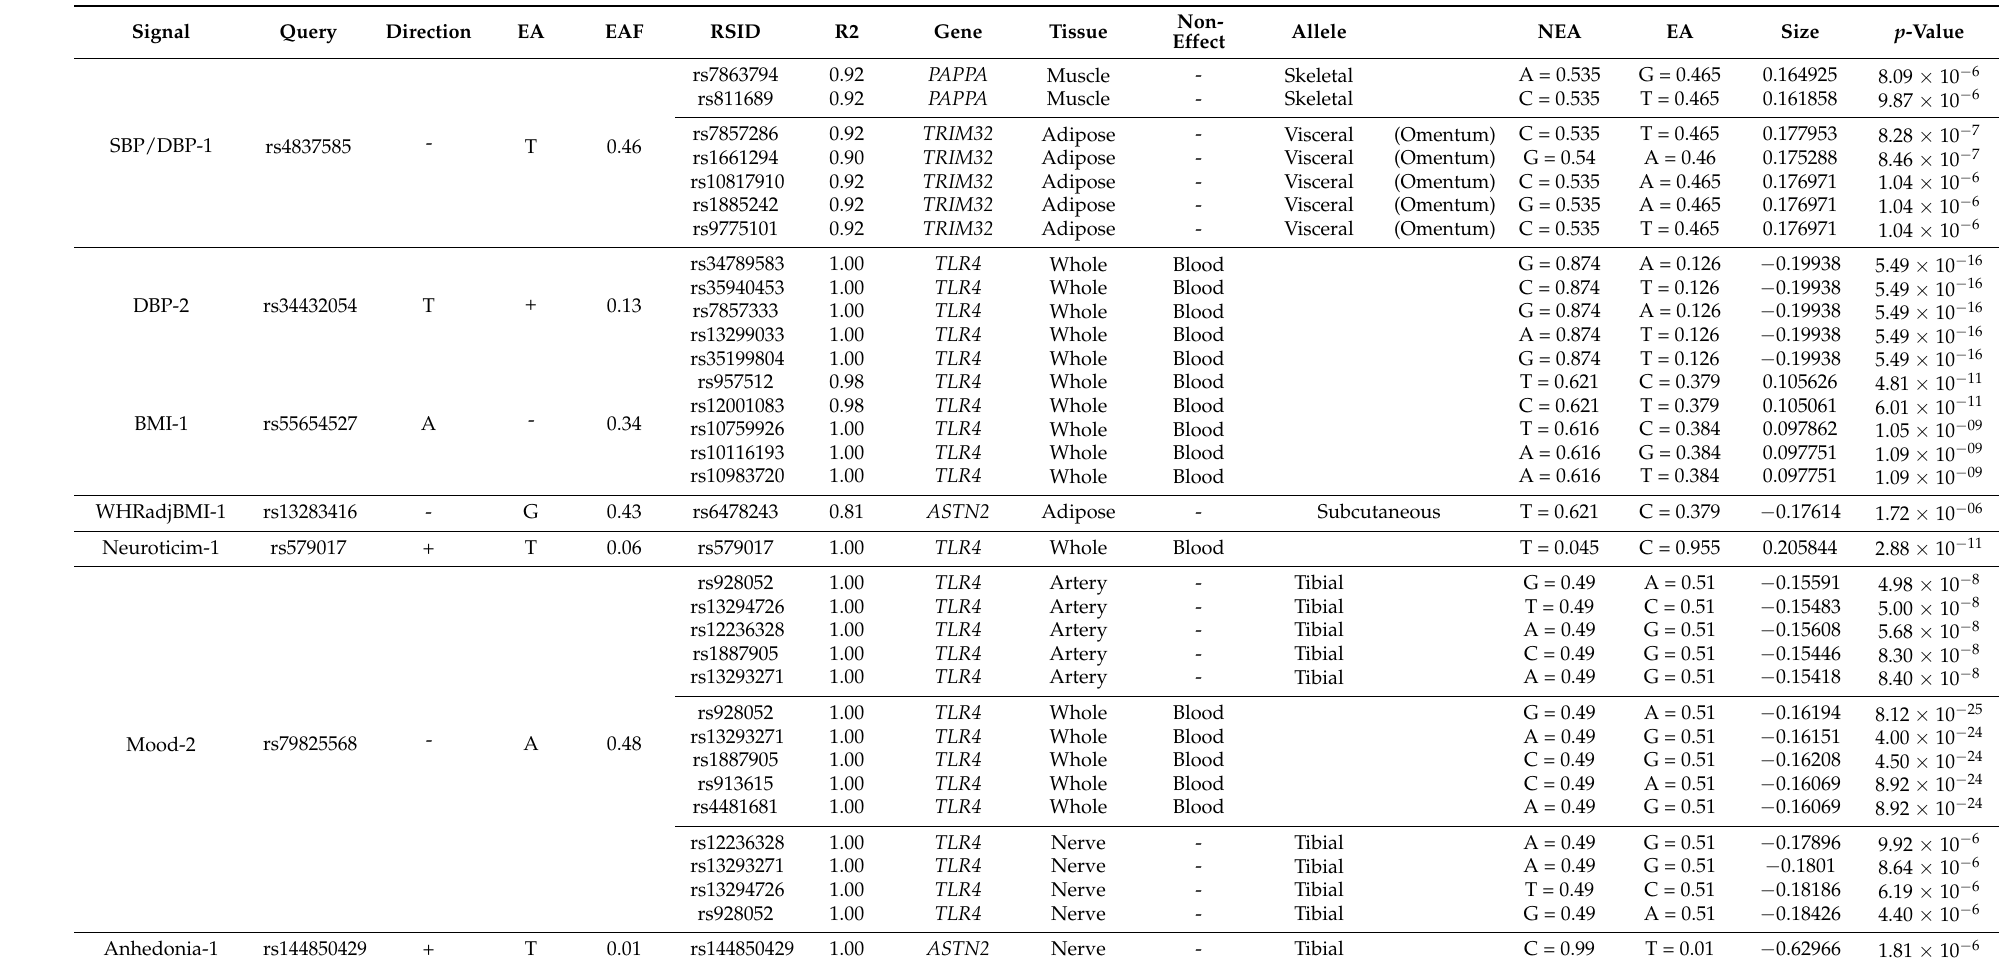
Table 4. Genotype-specific expression patterns in relevant